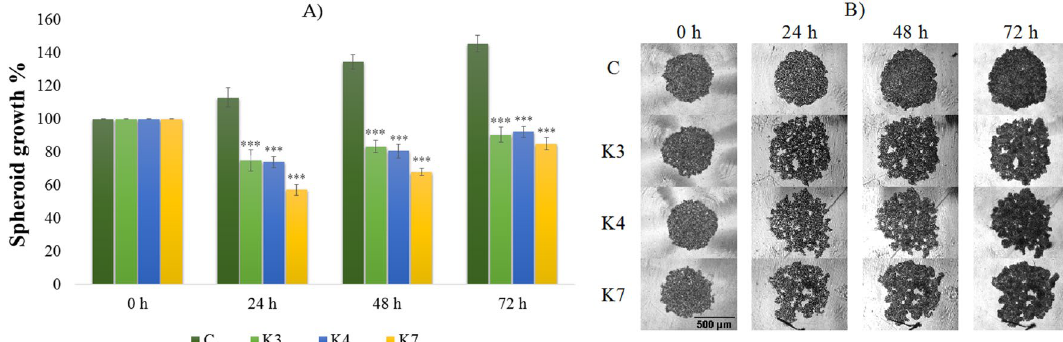
Figure 3. The impact of K3 , K4 , and K7 (1 µM) on sensitive HOC spheroid area after 24, 48, and 72 h exposure ( A ). Representative images of sensitive HOC spheroids at 0–72 h of experiment ( B ), scale bar = 500 µm. The control spheroids ( C ) were treated with 1% V/V DMSO. After incubation, the spheroid areas were determined and the spheroid growth was calculated ( A , relative to control). Data are expressed as the average of spheroid growth (%) of nine repetitions with the corresponding standard error of the mean. The statistical differences between the control spheroids and treated spheroids were calculated by using a two-compound t-test at the level *p < 0.05, **p < 0.01, ***p <